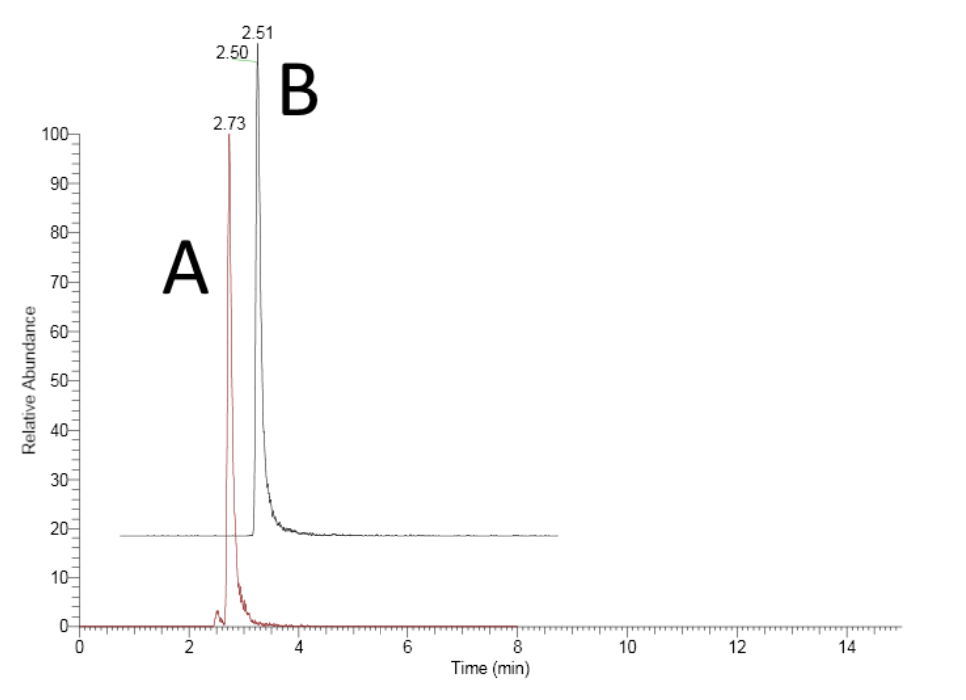
Figure 3. Chromatogram depicting the separation of π -MH ( A ) and τ -MH ( B ).